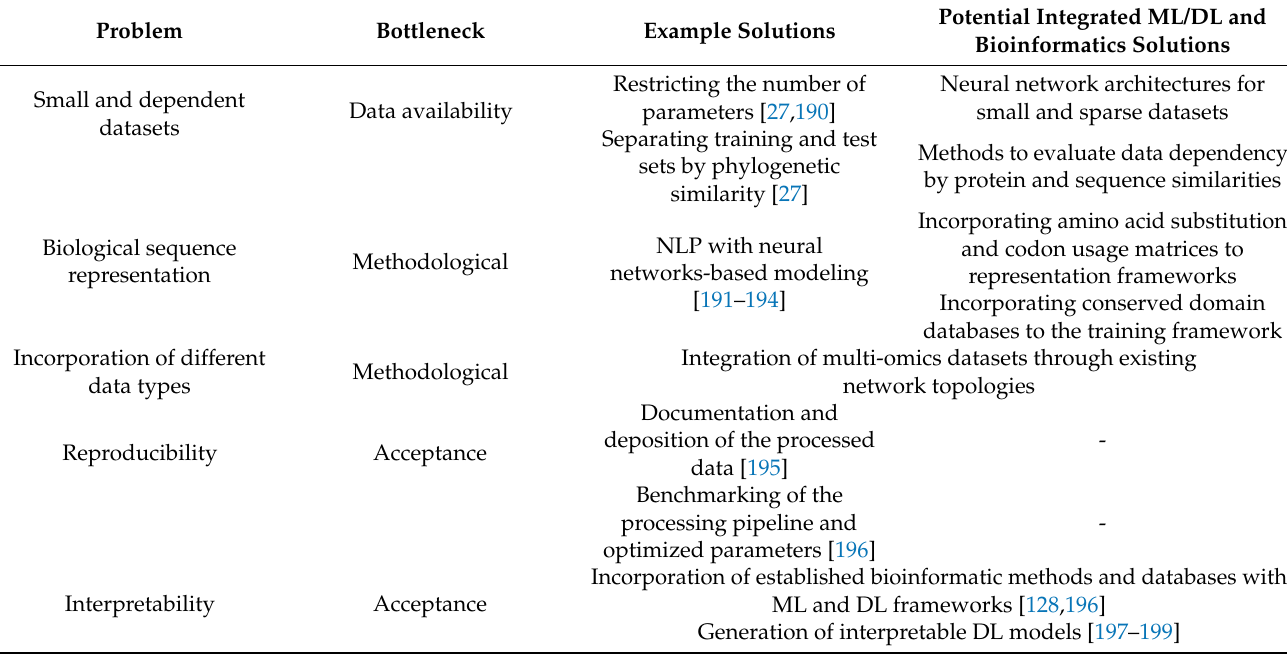
Table 2. Challenges posed for ML and DL in biomedicine, existing strategies to overcome these challenges and proposed solutions by integrating ML techniques with established bioinformatics